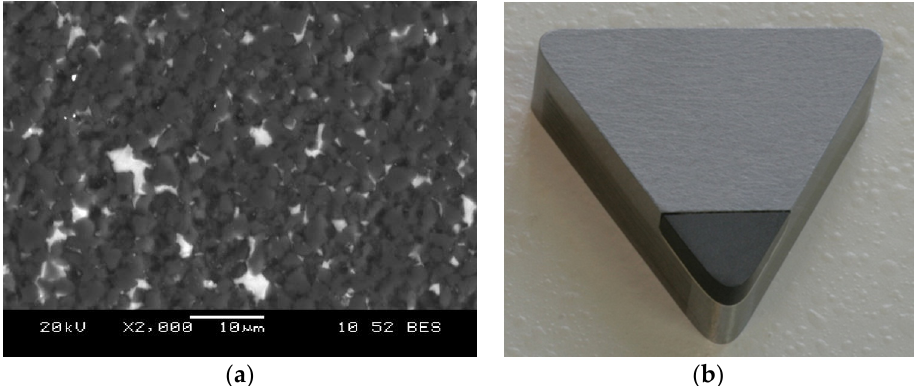
Figure 15. ( a ) Microstructure of the samples for a diamond composite with 5 wt.% TiB 2 and ( b ) an insert with a diamond cutting edge. insert with a diamond cutting